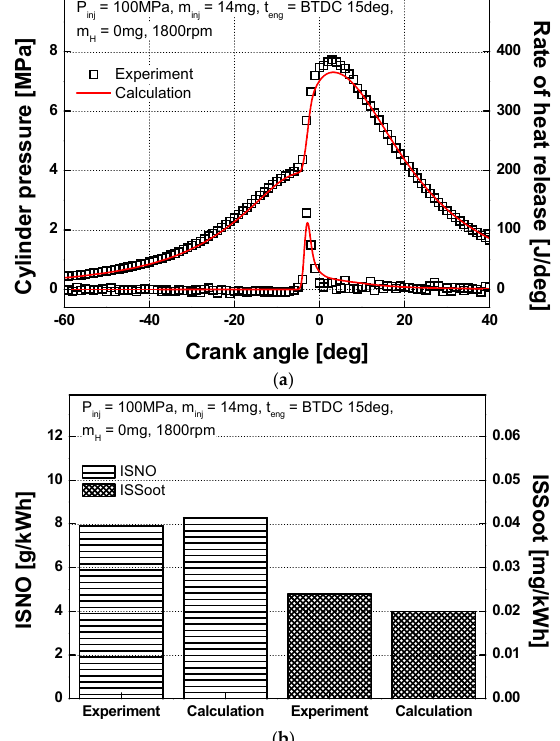
Figure 3. Reliability validation of numerical analysis with experimental results without water vapor injection. ( a ) Cylinder pressure and rate of heat release (ROHR); and ( b ) exhaust emissions. P inj = 100 MPa, m inj = 14 mg, t eng = BTDC (before top dead center) 15deg, m H = 0 mg, 1800